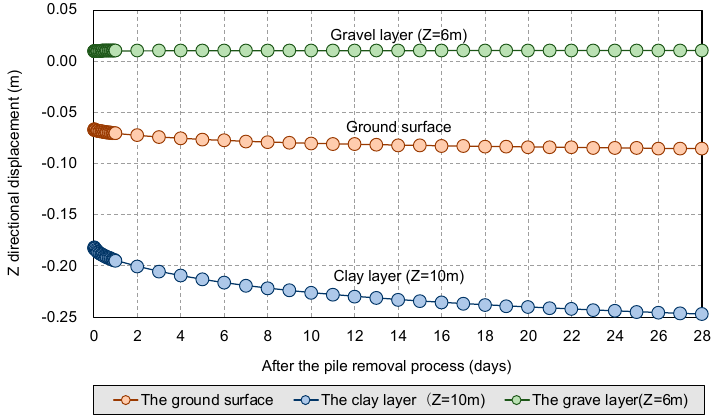
Figure 13. Subsidence of the surrounding ground after the formation of three extraction holes of removed piles.